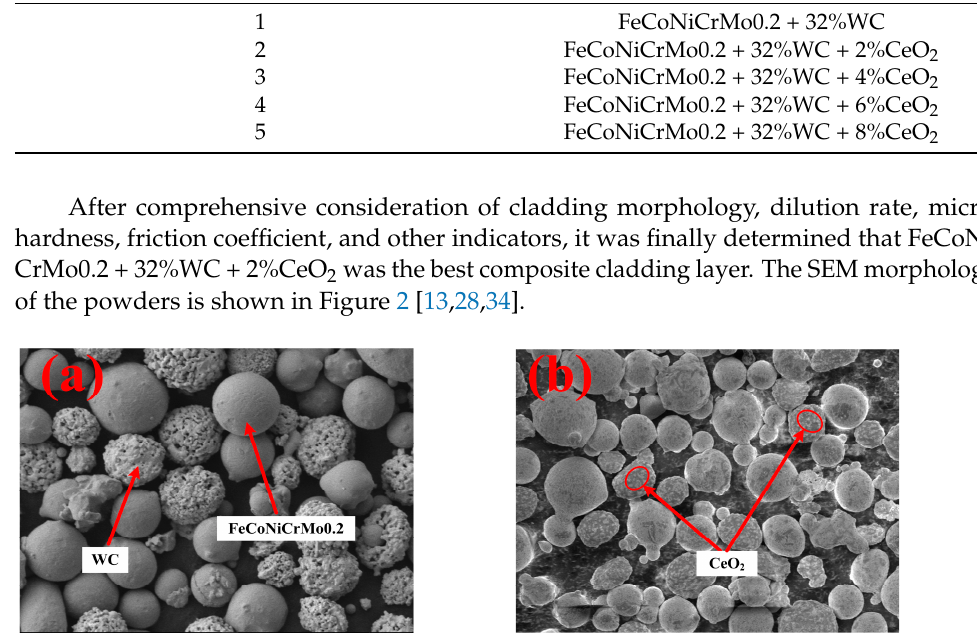
Figure 2. The morphology of the two composite powders: ( a ) FeCoNiCrMo0.2 + WC powder; ( b ) FeCoNiCrMo0.2 + WC + CeO 2 powder.